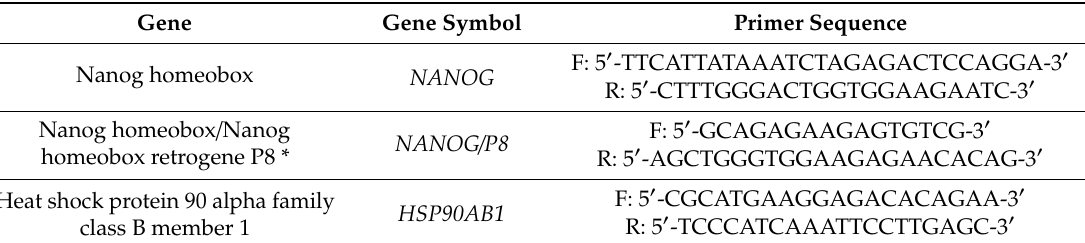
Table 3. Primers used in the